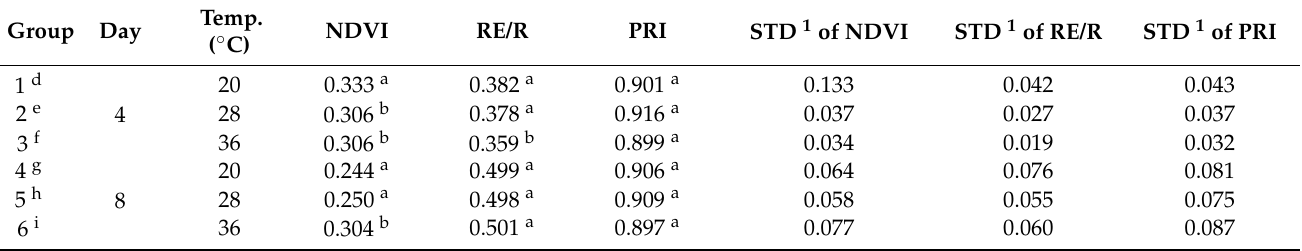
Table 3. Calculated normalized difference vegetation index (NDVI), red-edge ratio (RE/R), and photochemical reflectance index (PRI) and the corresponding multiple comparison analysis values of Chinese cabbage grown at 20 °C, 28 °C, and 36 °C for 4 and 8 days.